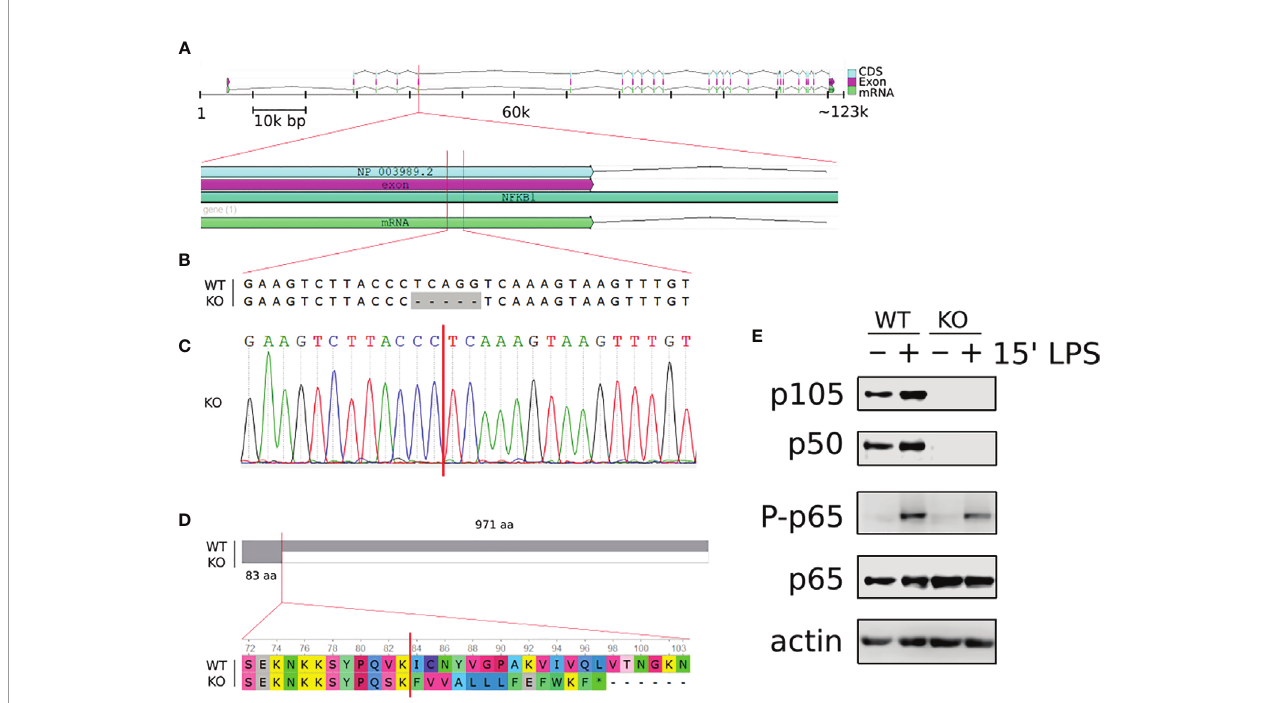
FIGURE 1 | Generation of NFKB1 -/- THP1 cells. (A) Schematic overview of homo sapiens NFKB1 gene organisation on chromosome 4; cDNA sequence (CDS), exon and mRNA are indicated. (B) Alignment of NFKB1 exon 5 DNA sequences of wild type (WT) and NFKB1 -/- (KO) cells showing CRISPR/Cas9 generated deletion. (C) Sanger sequencing chromatogram of exon 5 in NFKB1 -/- cells containing a frameshift mutation. (D) Alignment of NFKB1 open reading frames in WT and NFKB1 -/- cells, grey area indicates sequence identify. (E) PMA-induced macrophages from WT and NFKB1 -/- THP1 cells were stimulated with LPS (10 ng/mL) for 15 min, and p105/p50 ( NFKB1 protein products) analysed by western blot. Antibodies speci fi c for p65 phosphorylation at S536 (p-p65) were used to measure NF- k B pathway activation, anti- p65 and anti-actin antibodies were used as loading